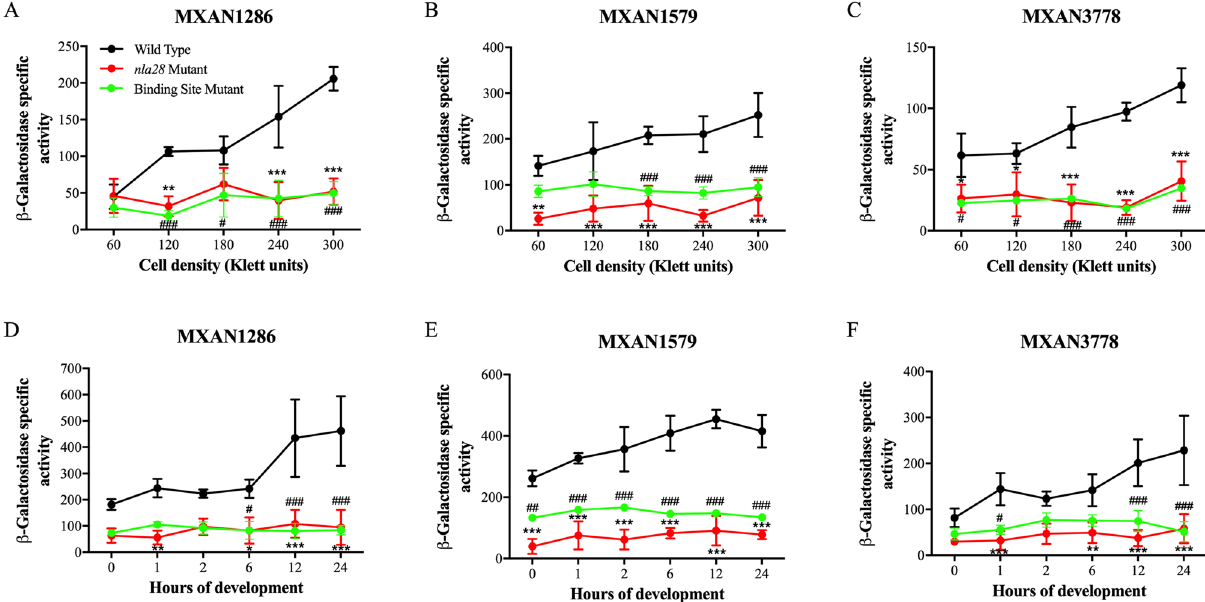
Figure 4. In vivo activities of MXAN1286, MXAN1579 and MXAN3778 promoters in nla28 mutant cells and when Nla28 binding sites are mutated. Wild-type fragments of the MXAN1286, MXAN1579 and MXAN3778 promoters were cloned into a lacZ expression vector and transferred to the wild-type M. xanthus strain DK1622 (Wild Type) or to a derivative of strain DK1622 with an inactivated nla28 gene ( nla28 Mutant). In addition, fragments of the MXAN1286, MXAN1579 and MXAN3778 promoters containing one mutated Nla28 half binding site were cloned into a lacZ expression vector and transferred to strain DK1622 (Binding Site Mutant). At various cell densities during growth ( A – C ) and time points during development ( D – F ), β-galactosidase- specific activities in cells carrying a wild-type or a mutant promoter fragment were determined. (N = 3 at each density or time point; error bars are standard deviations of the means; ***p < 0.001; **p < 0.01; *p < 0.05 for in vivo activities of wild-type promoters in nla28 mutant versus in wild-type cells; ### p < 0.001; ## p < 0.01; # p < 0.05 for in vivo activities of binding site mutant promoters versus wild-type promoters in wild-type